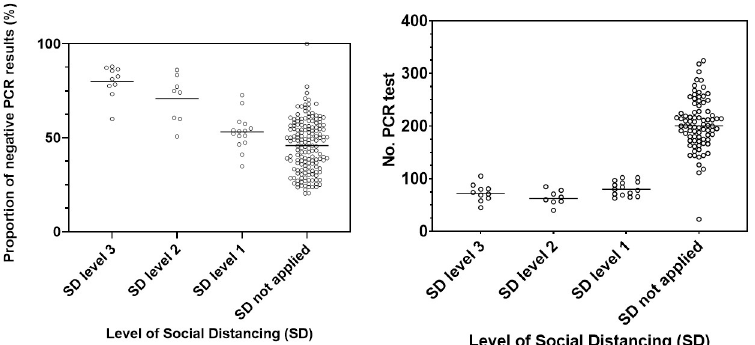
Fig 2. Mean proportion of negative respiratory virus PCR test results according to the level of social distancing (between the 1st week of 2015 and the 42nd week of 2020; a total of 303 weeks) and the mean number of respiratory virus tests according to the level of social distancing (between the 23rd week of 2017 and the 39th week of 2020; a total of 176 weeks). The horizontal line represents the mean value, and the hollow circle represents the value for each week. PCR, Polymerase chain reaction.